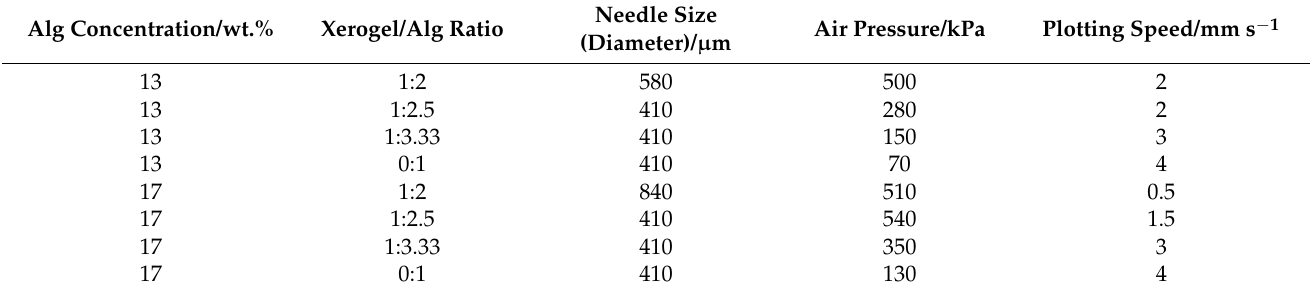
Table 1. Summary of plotting